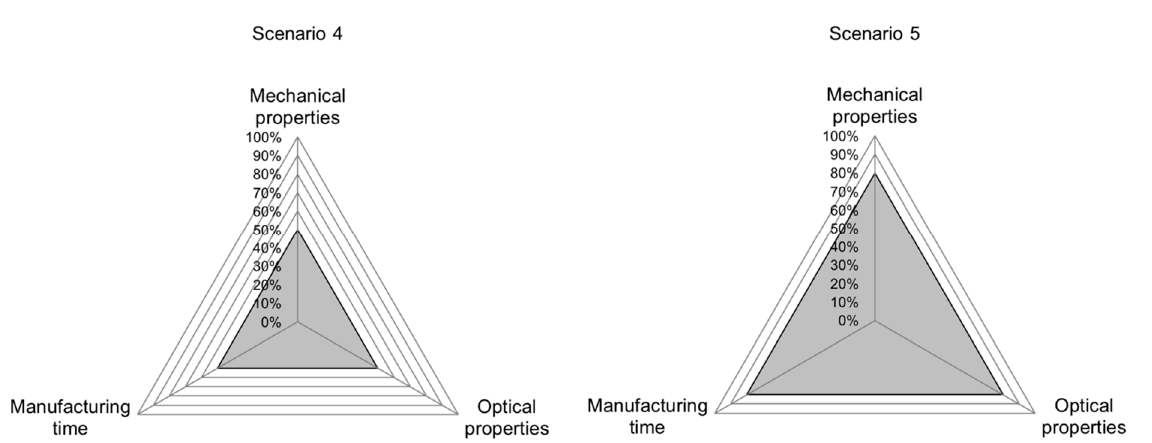
Figure 6. Scenarios 4 and 5 evaluate whether process parameters for medium and above-average part properties can be generated. The gray area shows the ful fi lment of each quality category.